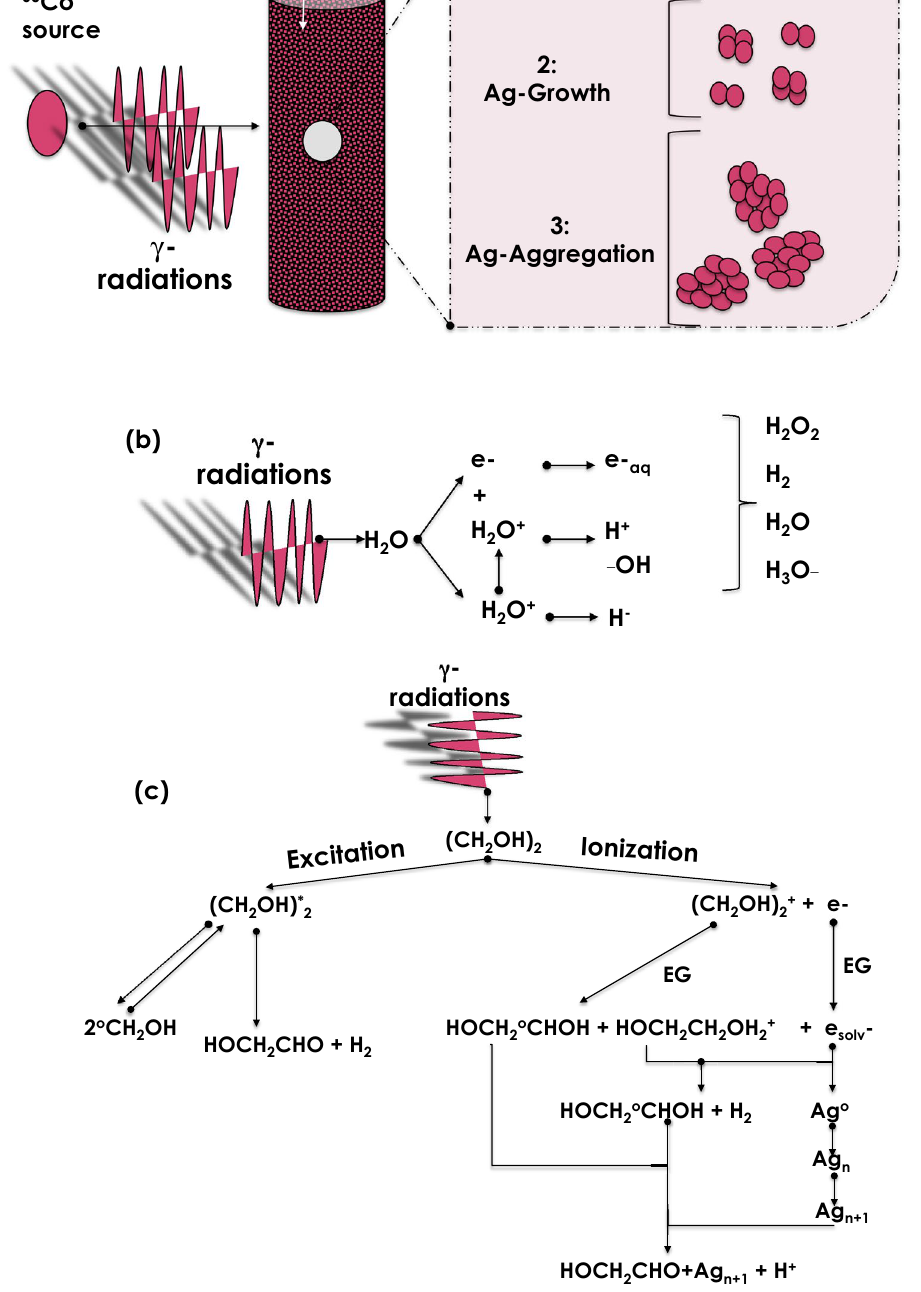
Figure 2. ( a ) Principle of the formation of nanofluids with gamma radiolysis of Ag nanoparticles dispersed in either H 2 O or C 2 H 6 O 2 , ( b ) major scavenging intermediates species including H 2 O + , H + , _ OH, H − , e − , and e − aq involved in the mechanism of H 2 O radiolysis, ( c ) major intermediates species and chemical reactions involved in the mechanism of C 2 H 6 O 2 radiolysis and the formation of colloidal suspensions of nano-scaled Ag